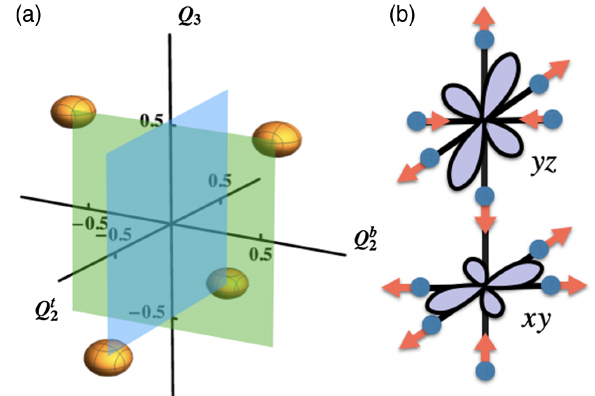
FIG. 7. (a) Four solutions corresponding to the total energy minimum of a pair of Jahn-Teller centers in a common corner geometry ( t 1 2 configuration, λ ¼ 0 ). Q 3 , Q b 2 , and Q t 2 are given in g units of g=B . (b) Distortions (and orbitals) corresponding to one of these minima.